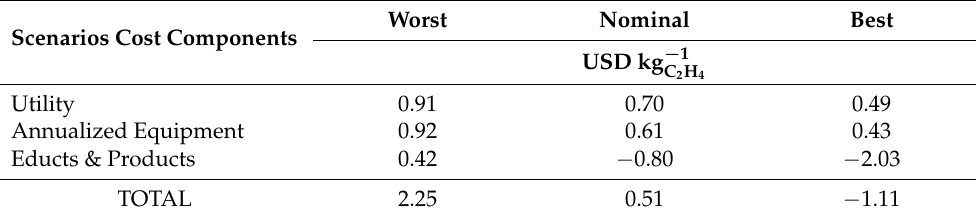
Table 6. Bio-ethylene production cost for different cost scenarios. Positive values mean cost, while negative values meaan